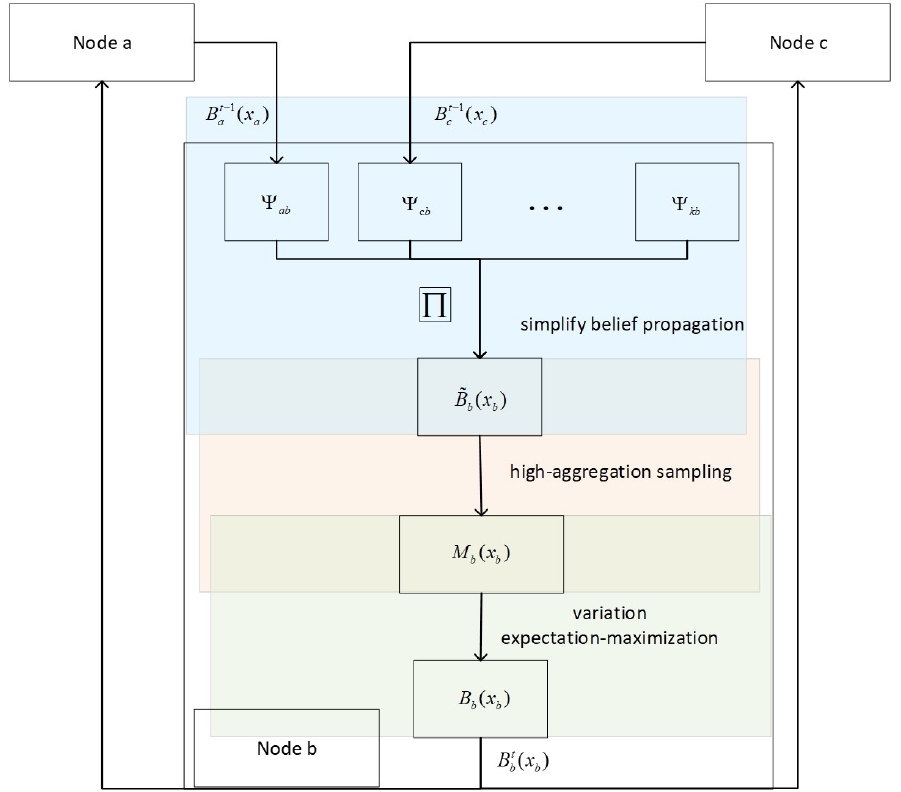
Figure 2. SBPVEM intra-node data flow. The node receives neighbors belief B i ∈G and computes potential function Ψ between nodes under the constraints of distance measurement. The belief ˜ B can be obtained by multiplying all the neighboring Ψ . ˜ B is complicated, by high-aggregation sampling and variation expectation–maximization, a GMM B is obtained to represent ˜ B